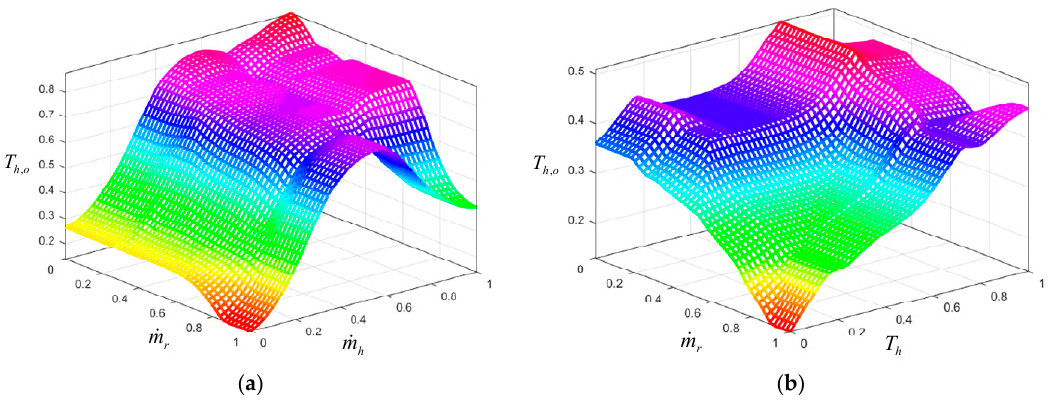
. . . m  and m  ( a ) m  and m r and m h ( a ) m r and T h ( b r h r